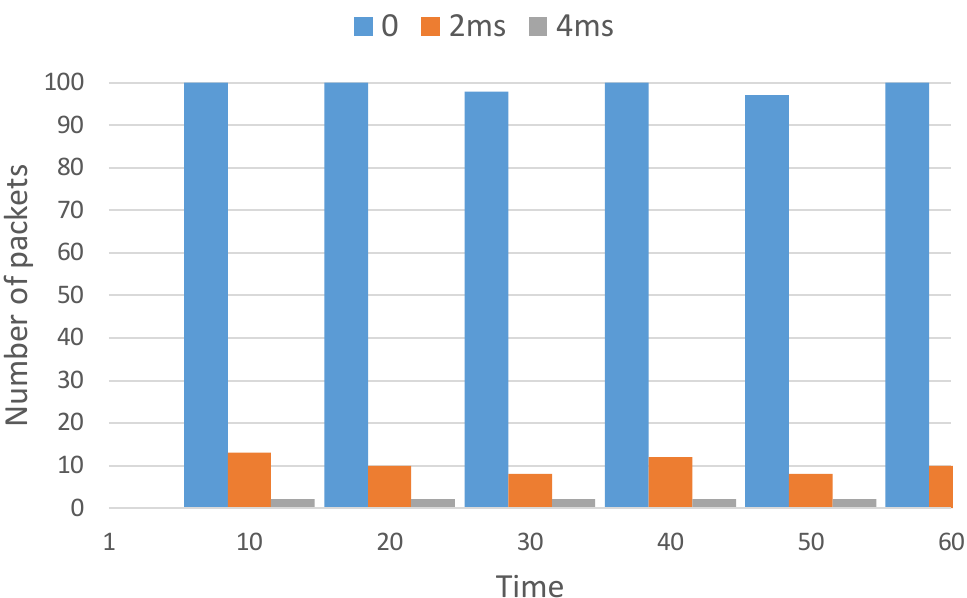
Figure 4. Number of DID documents transferred over the backbone link if 0, 2, or 4 ms delay is added before responding to DID document